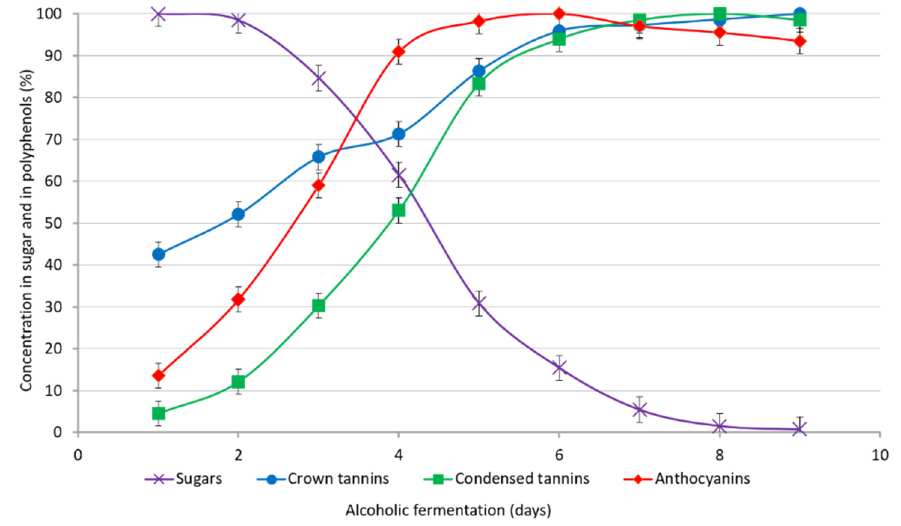
Figure 2. Evolution of sugar (in purple), anthocyanins (in red), condensed tannins (in green), and crown procyanidins’ tetramer (in blue) during the alcoholic fermentation expressed as a percentage according to their maximum concentration.